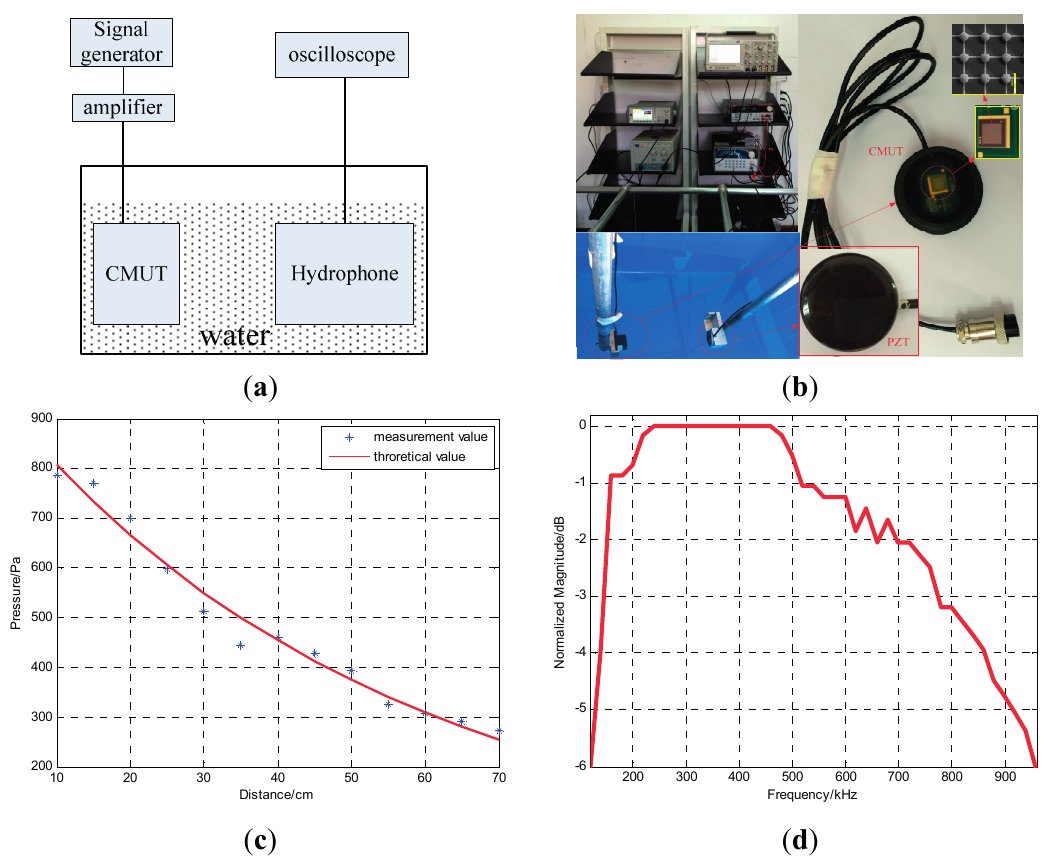
Figure 5. ( a ) The experimental schematic diagram ( b ) The experimental configuration ( c ) the measurement and theoretical pressures at different distances ( d ) The − 6 dB